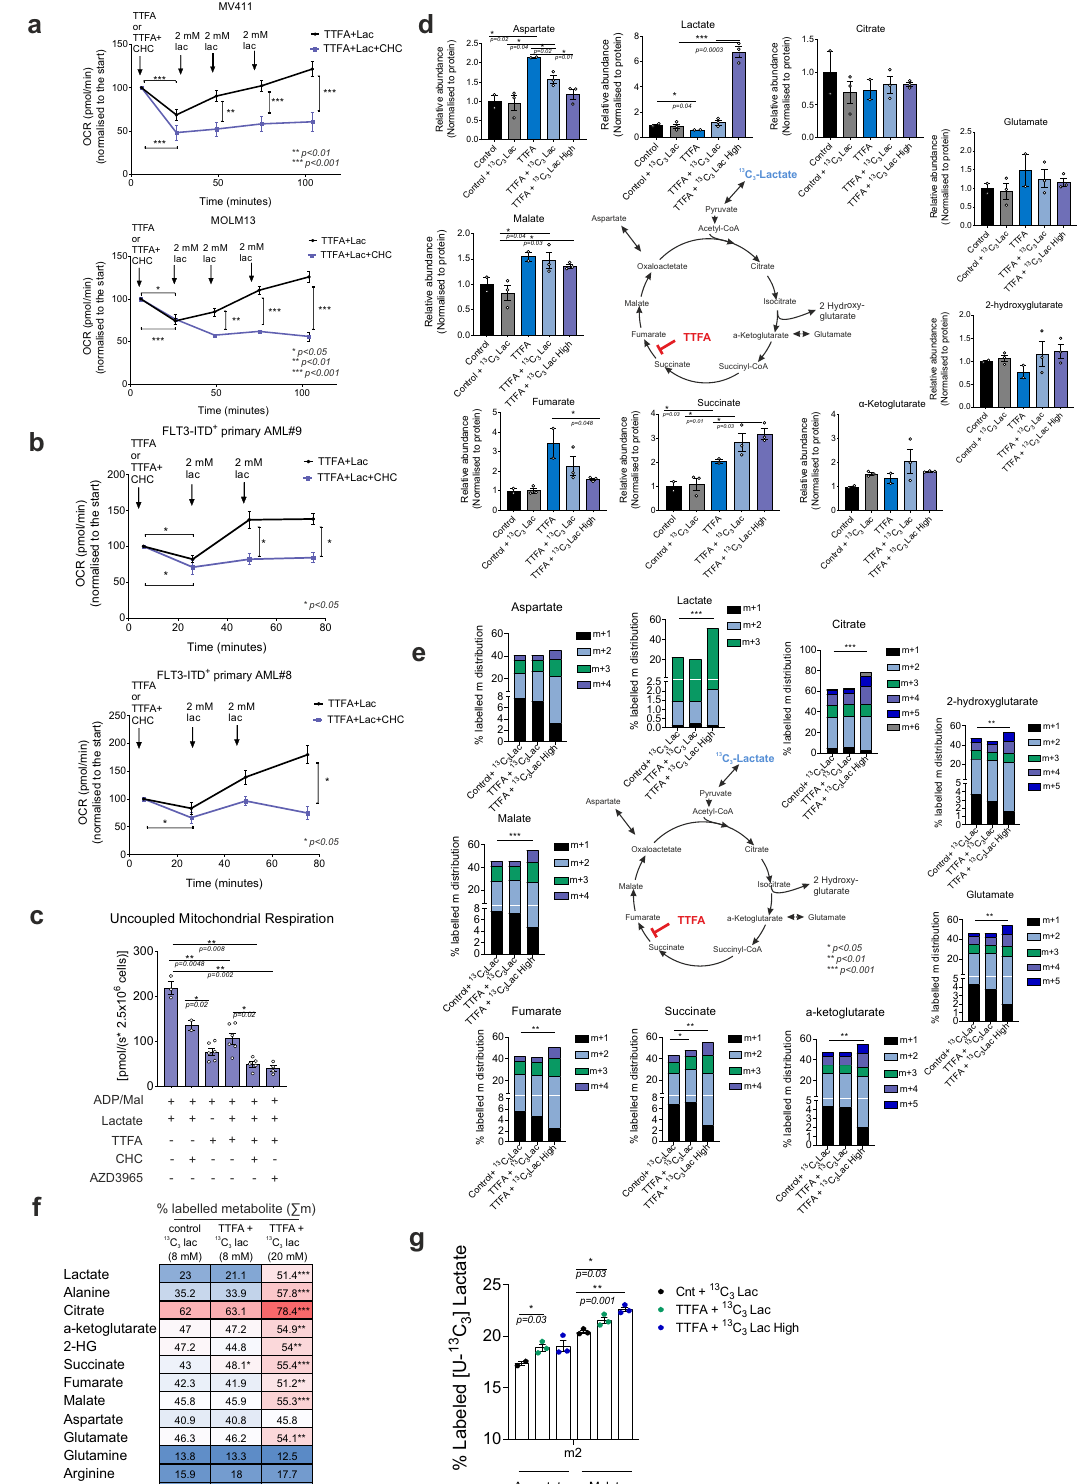
(Supplementary Fig. 5g) and leukemic cell counts per femur (Supplementary Fig. 5h). While monotherapies already slightly delayed leukemia development in mice transplanted with FLT3 - ITD + MV4 – 11, co-inhibition of lactate import and ETC complex II signi fi cantly further delayed leukemia onset compared to the vehicle group (Fig.